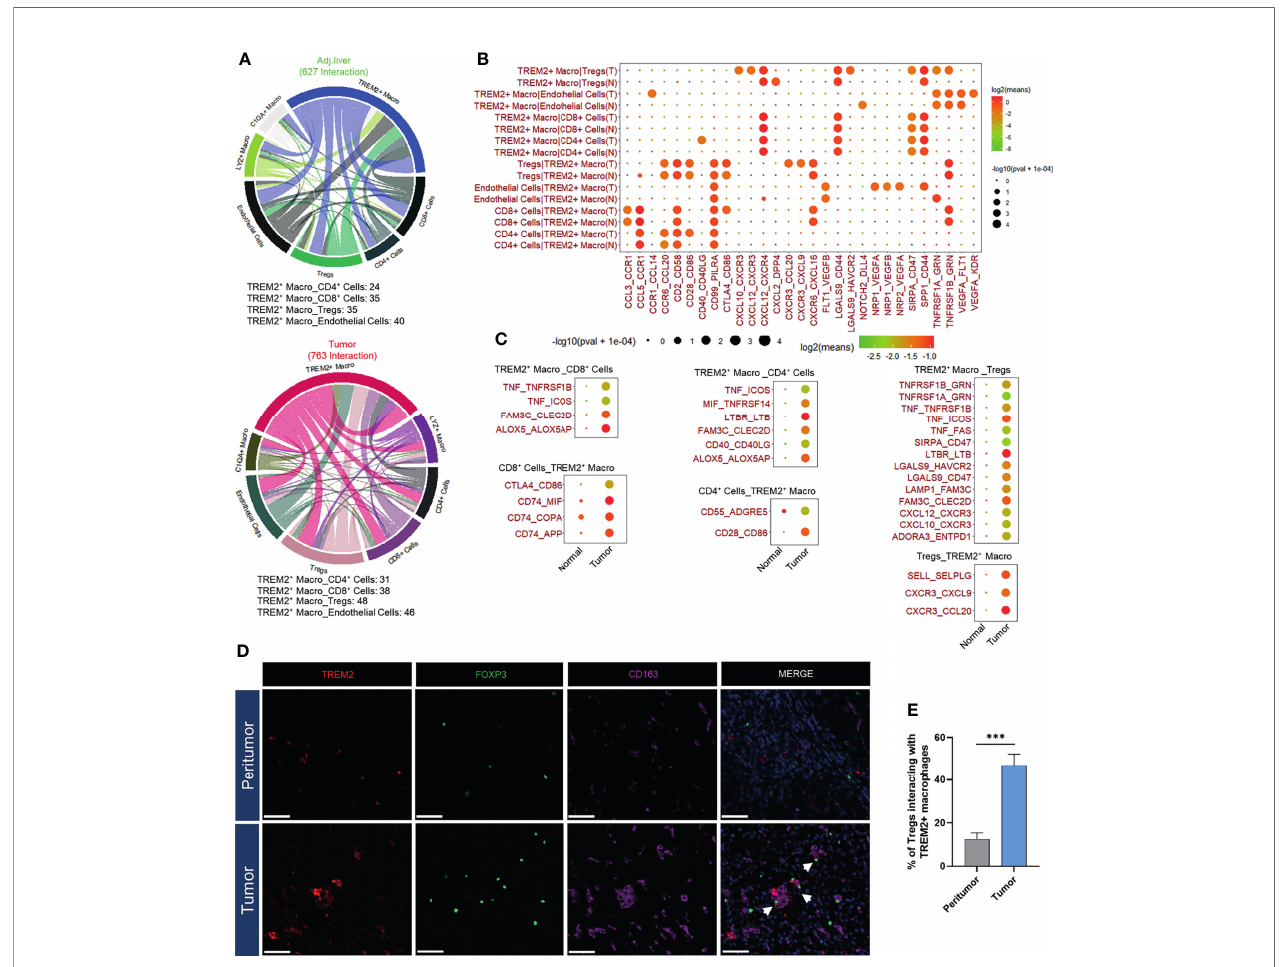
FIGURE 5 | Characterization of the TREM2 + macrophage-based cellular interactome. (A) Chord diagrams of the cellular interactome between TREM2 + macrophages, T cells, and endothelial cells in adjacent liver and tumor tissues constructed by CellPhoneDB. (B) Bubble plot showing ligand-receptor interactions between TREM2 + macrophages, T cells, and endothelial cells in adjacent liver and tumor samples. Rows represent each cell-cell interaction pair, and columns de fi ne ligand-receptor pairs. The sizes of the bubbles indicate the signi fi cance of the interactions, as calculated by CellPhoneDB. (C) Dot plot of HCC-speci fi c ligand- receptor interactions of TREM2 + macrophages with T cells. (D) Representative immuno fl uorescence images of TREM2, CD163, and FOXP3 staining in HCC and peritumor tissues. Arrows denote the proximity of TREM2 + CD163 + macrophages and FOXP3 + Treg cells. The scale bar represents 50 m m. (E) Quanti fi cation of FOXP3 + Tregs interacting with TREM2 + macrophages in tumors and peritumor tissues. Signi fi cance was determined by Student ’ s t